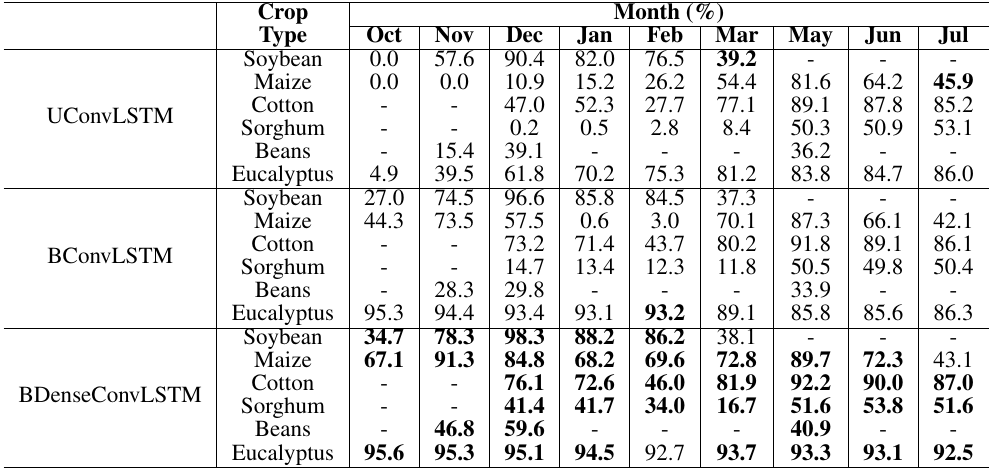
Table 4. Average F1 score for the most relevant crop types in Campo Verde study area, computed at each date from Crop Type Soybean M T S L onv